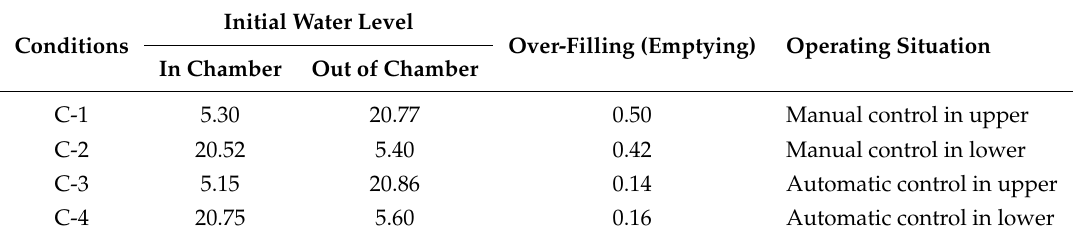
Table 4. The conditions of the hydrodynamics test (unit: